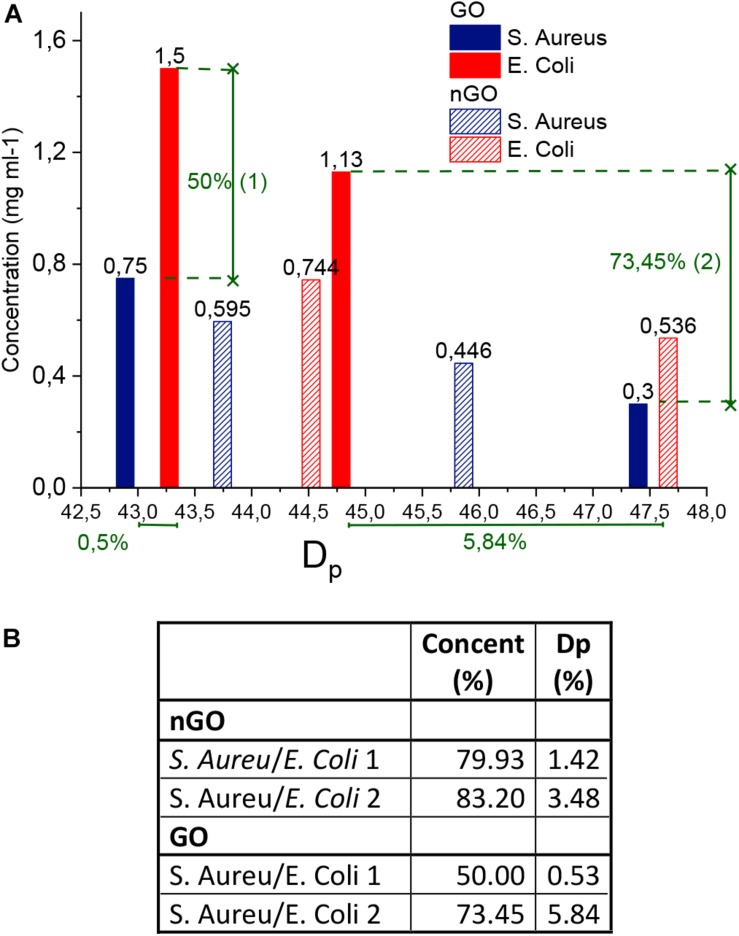
Threshold dose parameters. (A)
Dp. (B) Ratio of concentrations (%) and reduction percentage in ratios of GO and nGO for S. aureus and E. coli [(1-ratio)∗100%].